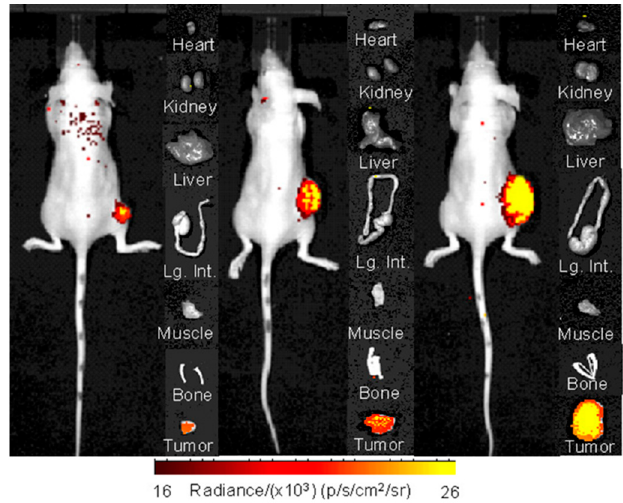
Figure 3. Cerenkov luminescence imaging of FAP + U87MG tumor-bearing mice at 72 h p.i. using [ 89 Zr]Zr-Df-Bz-F19.